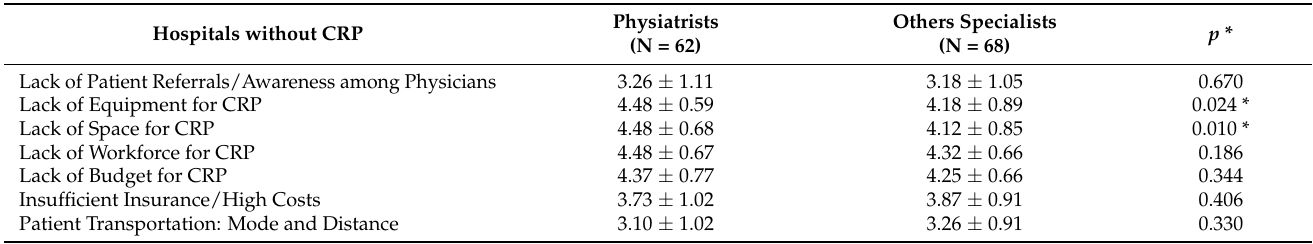
Table 5. Barriers and factors relating to cardiac rehabilitation at hospitals without cardiac rehabilita- tion programs